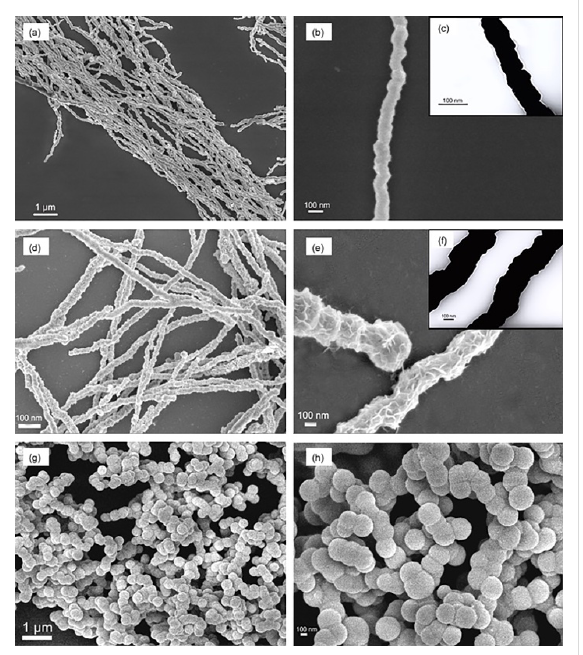
Figure 1: SEM images of cobalt nanowires prepared under an external magnetic field with PVP (a,b) and without PVP (d,e), and cobalt nano- wires prepared without an external magnetic field (g,h). The insets (c, f) show the corresponding TEM images of cobalt nanowires (b,e), re-